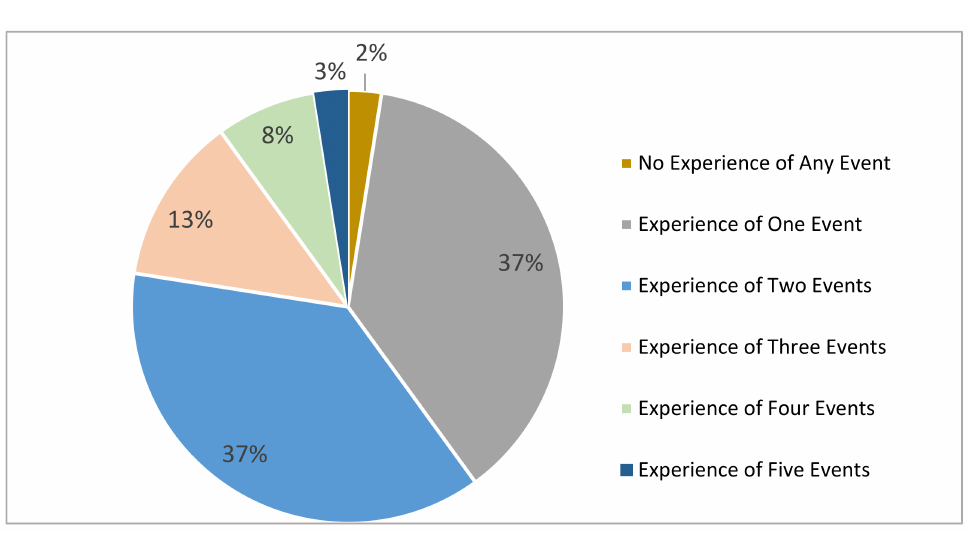
Figure 4. Disaster/hazard event experience.